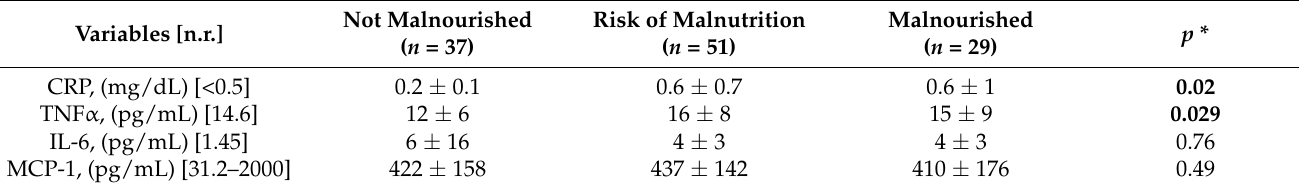
Table 3. Comparison of inflammatory markers between not malnourished, at risk of malnutrition and malnourished